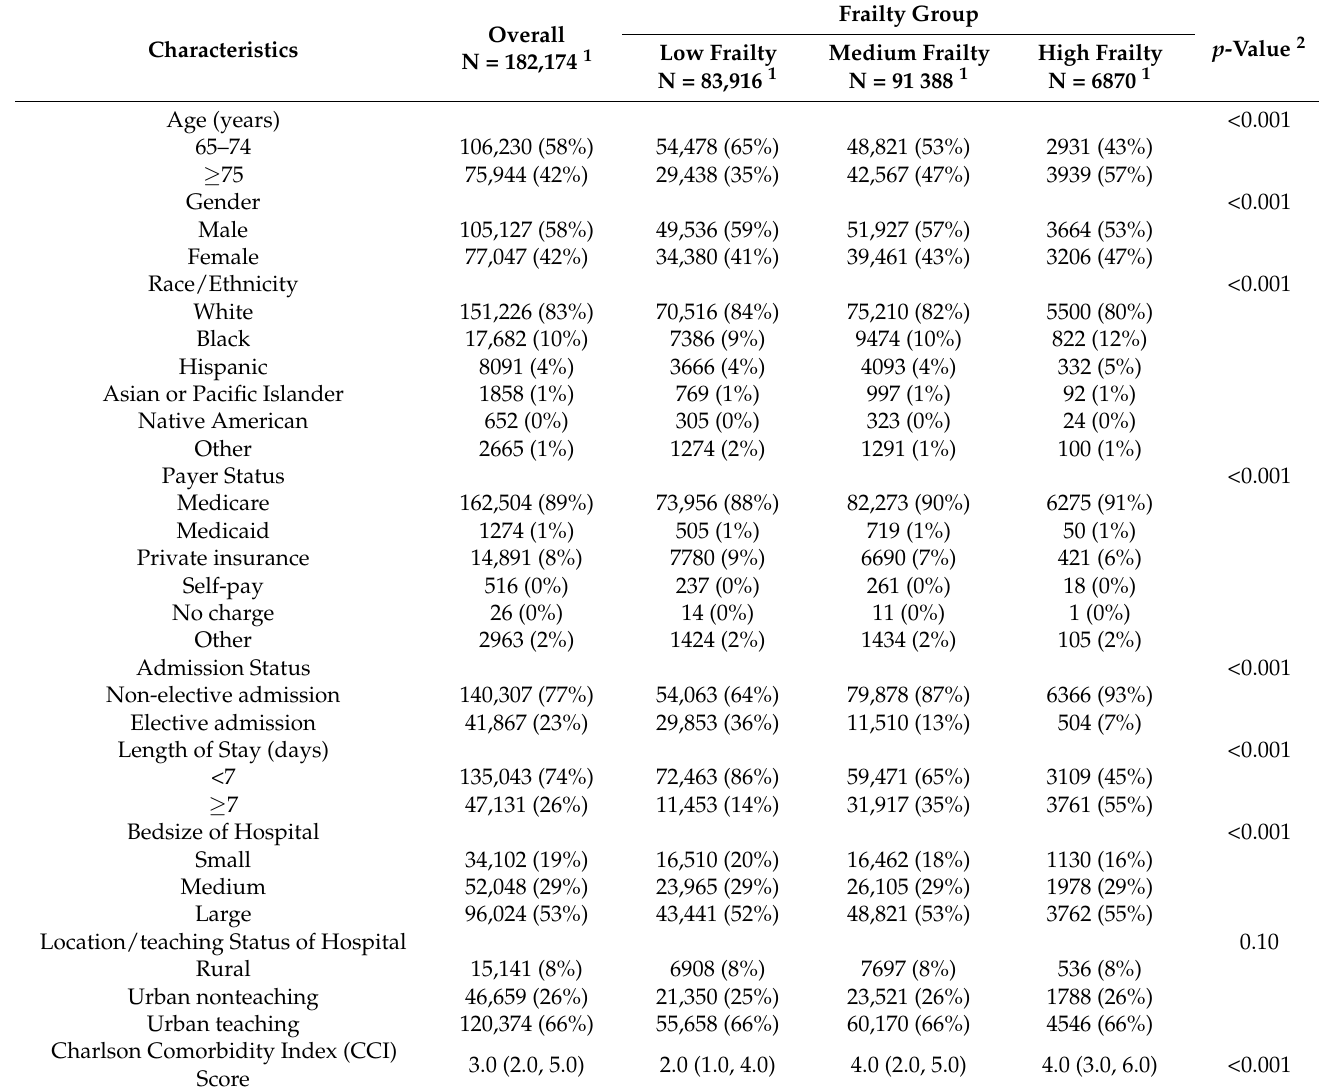
Table 1. Baseline Characteristics of Hospitalized OSA